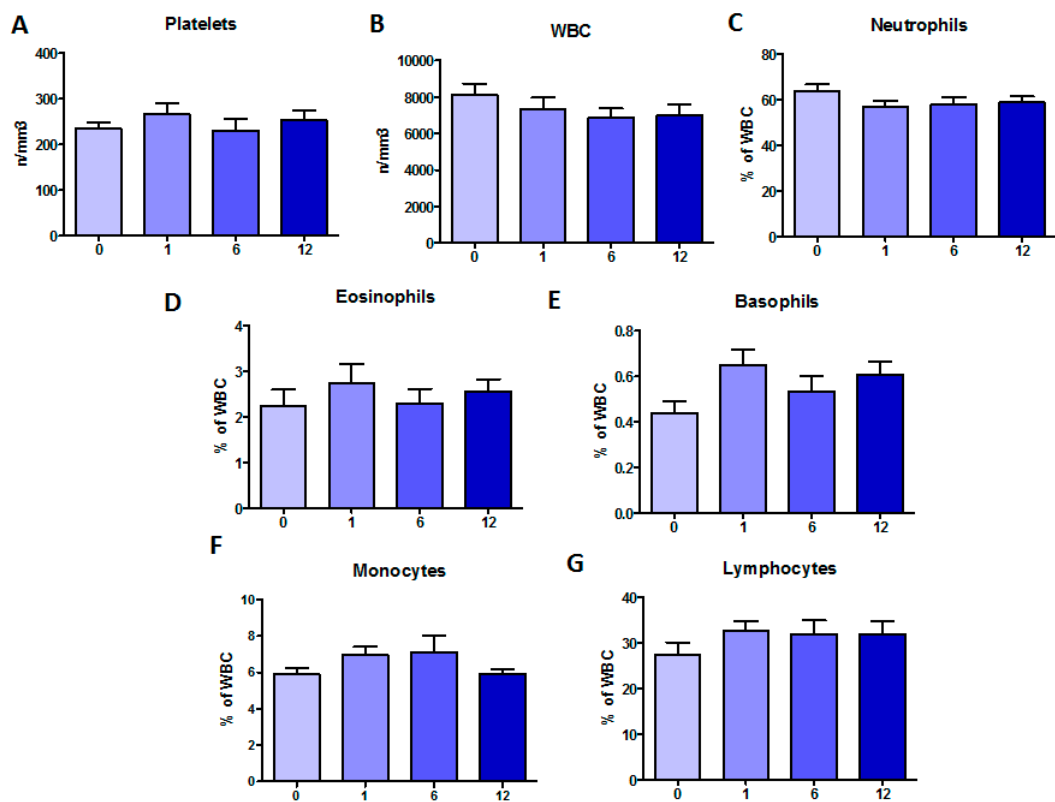
Figure 2. Changes in marrow-derived peripheral cells during Orkambi ® treatment: ( A ) platelets (n / mm 3 ); ( B ) total WBC (n / mm 3 ); ( C ) neutrophils (% of WBC); ( D ) eosinophils (% of WBC); ( E ) basophils (% of WBC); ( F ) monocytes (% of WBC); and ( G ) lymphocytes (% of WBC). Data are shown as mean ± SEM.